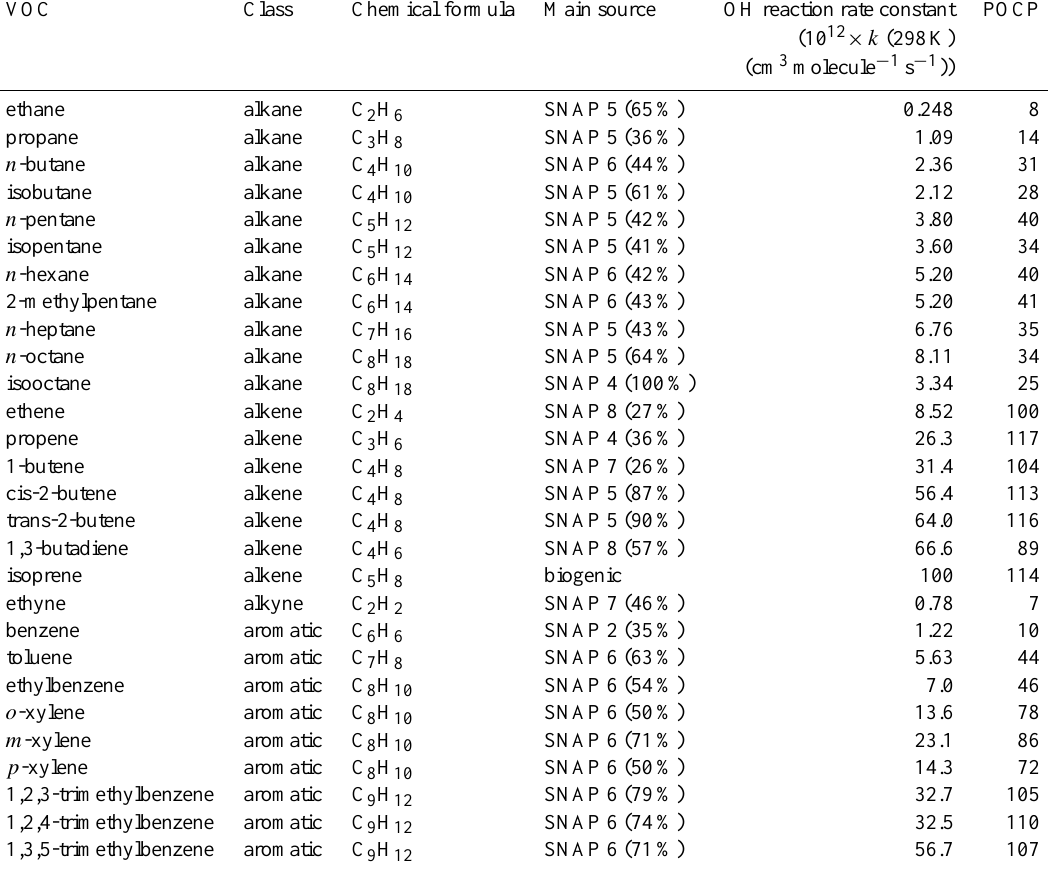
Table 1. Summary data for the measured VOCs at Auchencorth and Harwell (note that m -xylene and p -xylene are reported as a single measurement). The rate coefficients at 298K for reactions of each VOC with OH are taken from Atkinson and Arey (2003), and the POCPs are from Derwent et al. (2007a). The “main source” column gives the SNAP sector with the largest contribution of that VOC to UK annual anthropogenic emissions in 2011, with the exception of isoprene which is mainly of biogenic origin (defined in Sect. 2.3). The listed SNAP sectors are SNAP 2, non-industrial combustion plants; SNAP 4, production processes; SNAP 5, extraction and distribution of fossil fuels; SNAP 6, solvent use; SNAP 7, road transport; and SNAP 8, non-road